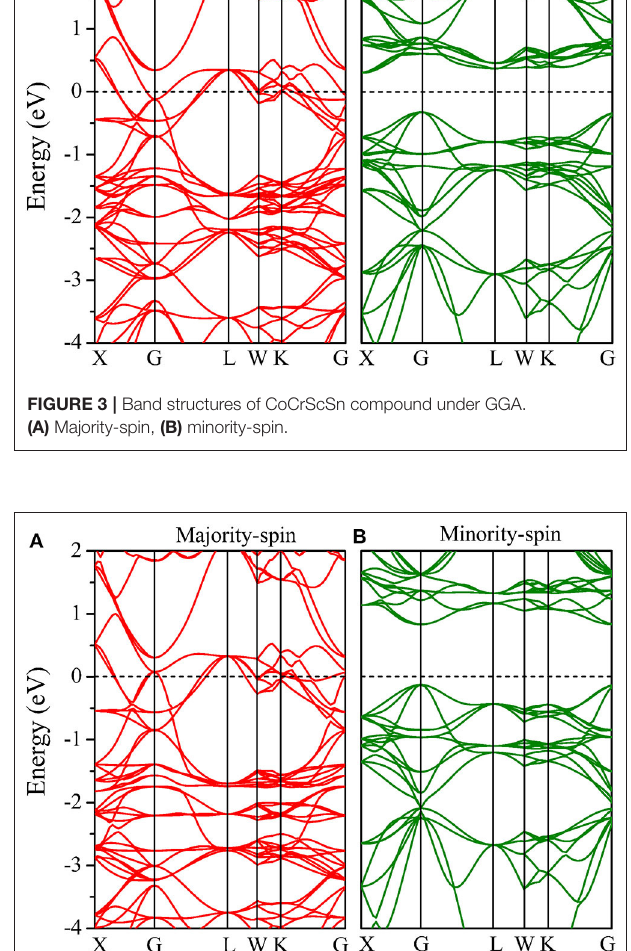
FIGURE 4 | Band structures of CoCrScSn compound under GGA + U. (A) Majority-spin, (B)